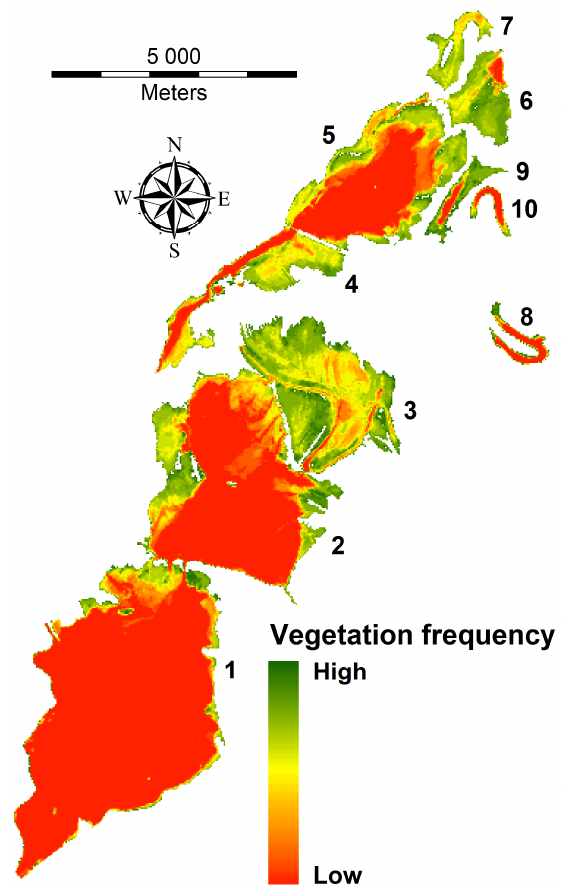
Figure 9. Map to summarize vegetation frequency over the period between 1984 and 2017. A greener area means more vegetation cover, while the red color denotes an open water surface.